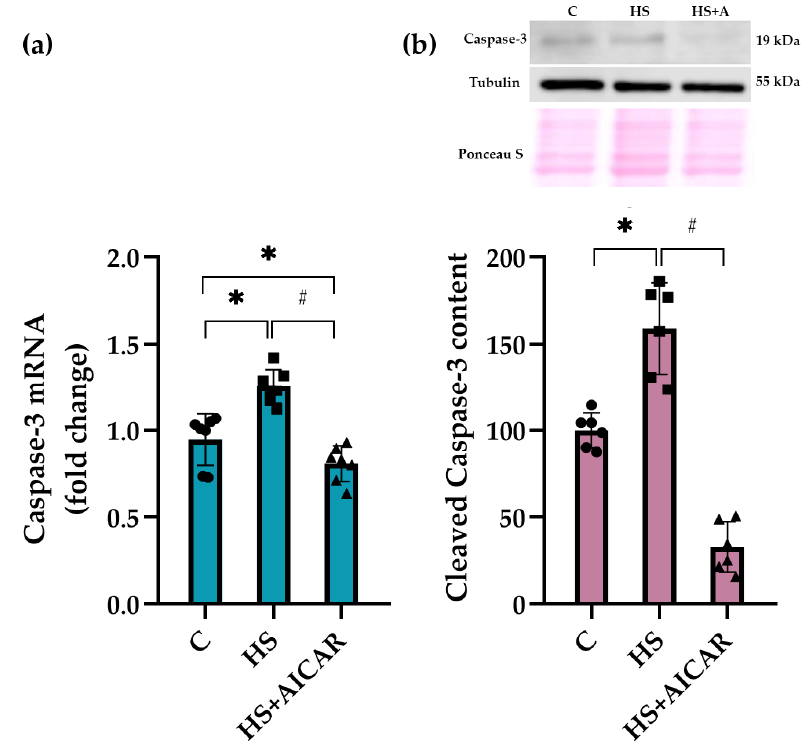
Figure 6. Effect of AICAR treatment on ( a ) caspase-3 mRNA expression and ( b ) cleaved caspase-3 protein content in differentiating myoblasts derived from the atrophied rat soleus muscle. C—myoblasts derived from rat soleus muscle of the control rats, HS—myoblasts derived from rat soleus muscle after 7-day HS, HS+AICAR—myoblasts derived from rat soleus muscle after 7-day HS and treated with AICAR. Values are means ± SEM, expressed as fold changes vs. C (PCR data, n = 7) or as % of C (WB data, n = 6). Dots, squares and triangles on the bars represent individual data points. *— p < 0.05 vs. C; #— p < 0.05 vs. HS.